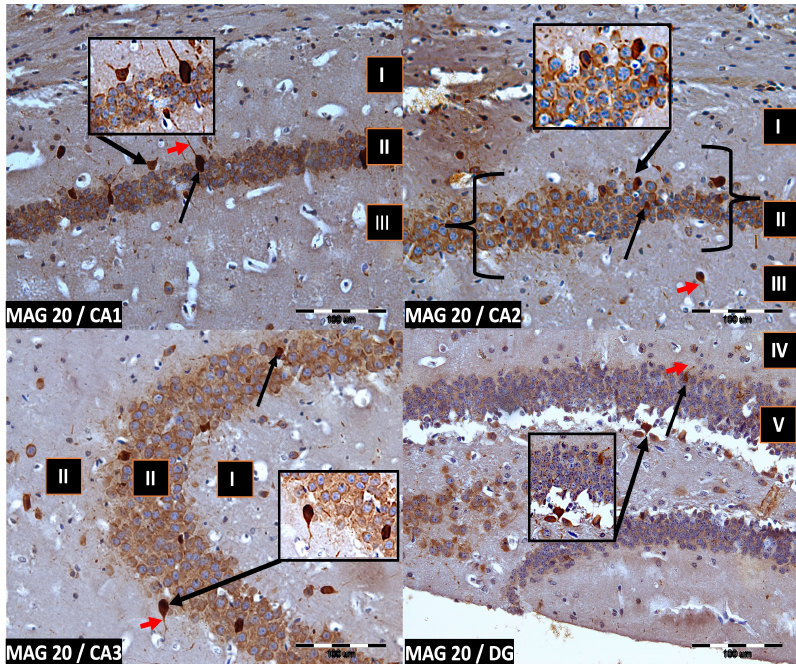
Figure 3. Group MAG10. Immunoreactivity of PV-IR neurons in the fi elds CA1–CA3 and the DG of the mouse hippocampus was observed. I. the marginal layer, II. the pyramidal layer, III. the multi- form layer, IV. the molecular layer, V. the granular layer. The arrows indicate PV-IR neurons (black arrow) and PV-IR nerve fi bers (red arrow) in the hippocampus. Magni fi cation ×20 .